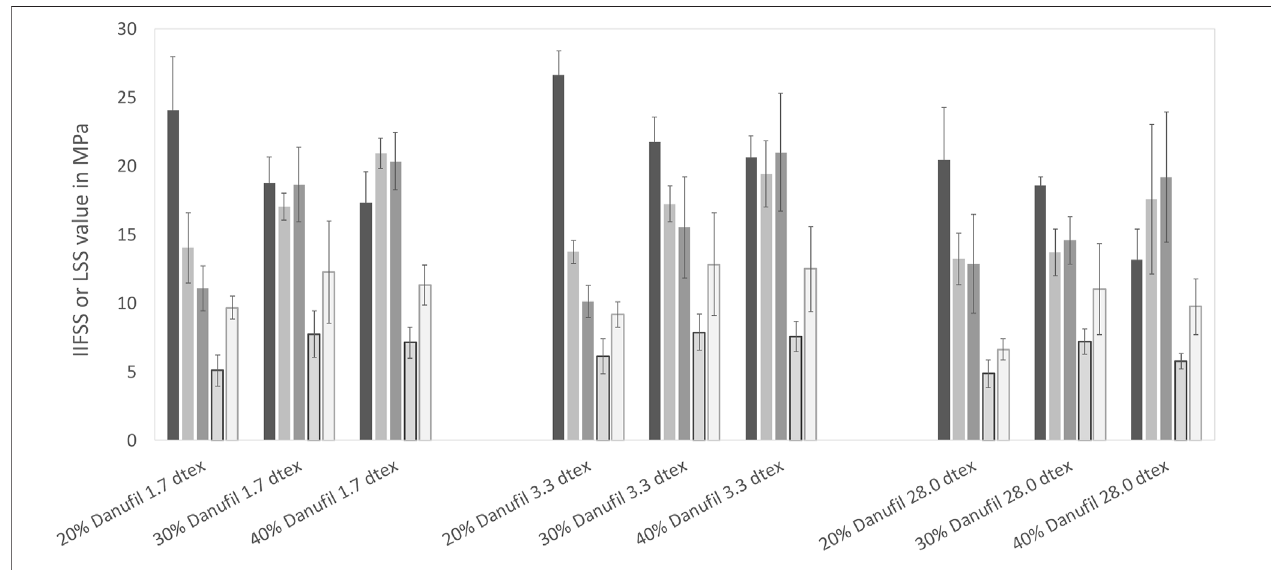
FIGURE 13| Comparison of apparent IFSS data from transversetensile and ILSS data obtained by short beam shear, SENB, double-notched tensile and double- notched compression tests. Results are shown as mean values with standard deviations as error bars.